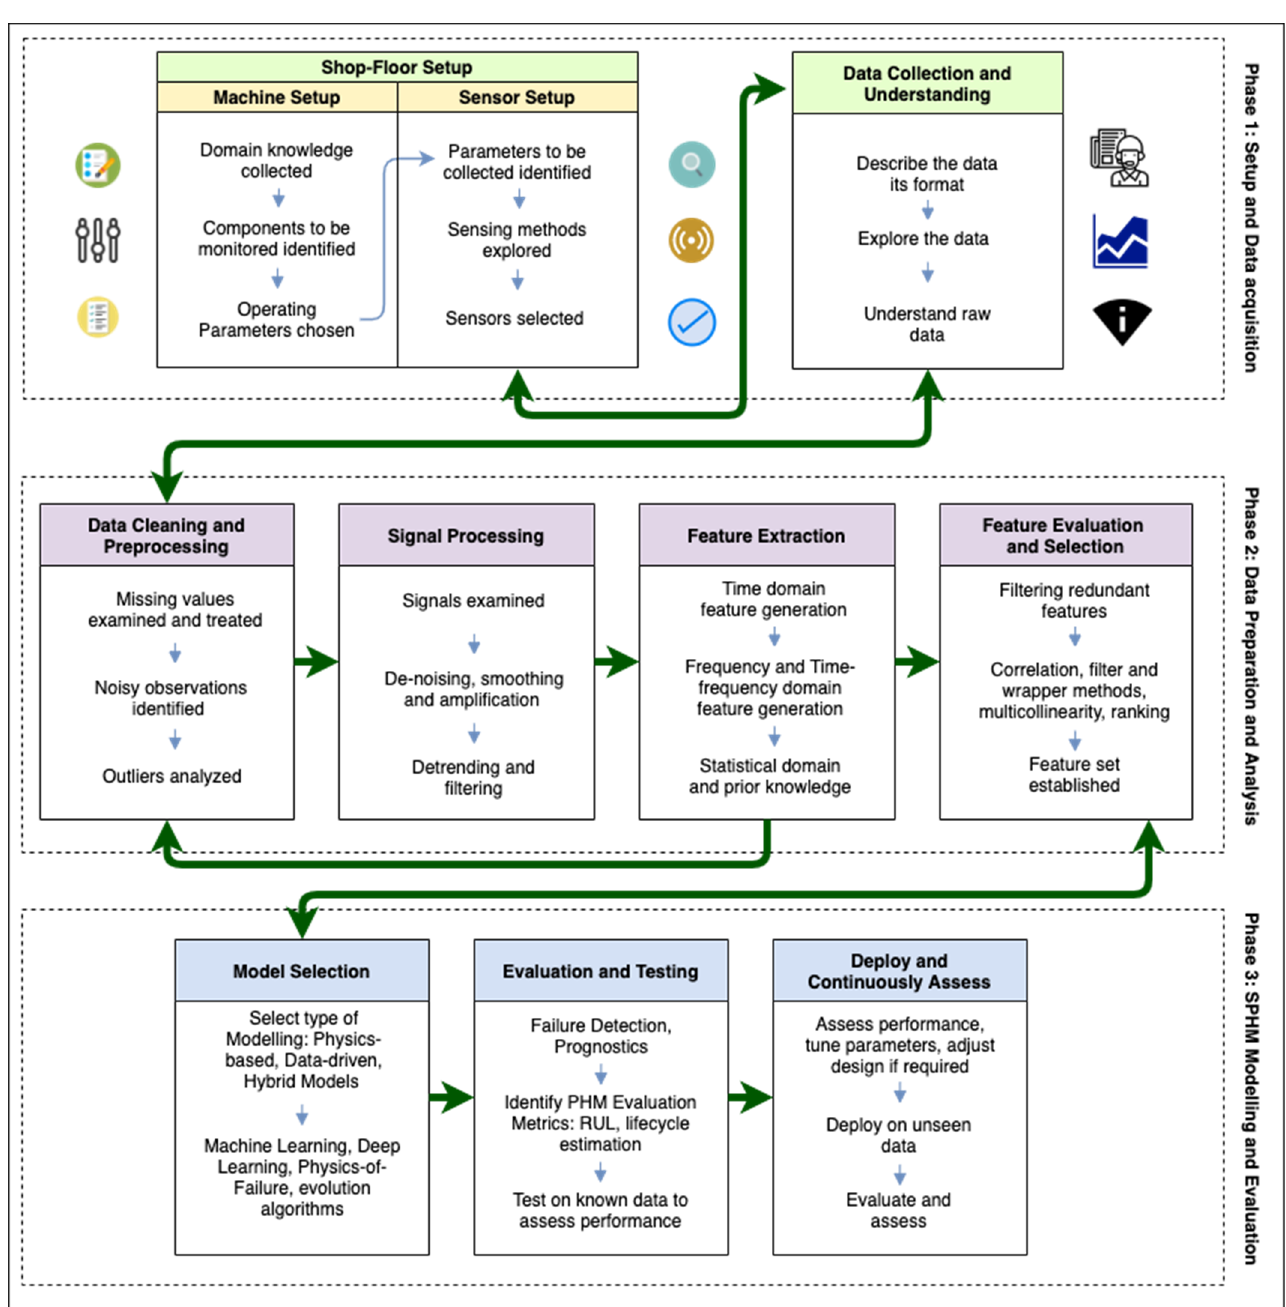
Figure 2. An interoperable framework for Smart Prognostics and Health Management (SPHM) in Smart Manufacturing (SM).